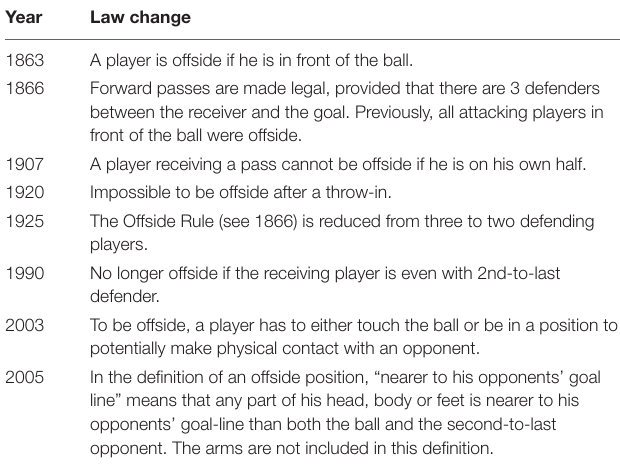
TABLE 1 | Brief history of the offside